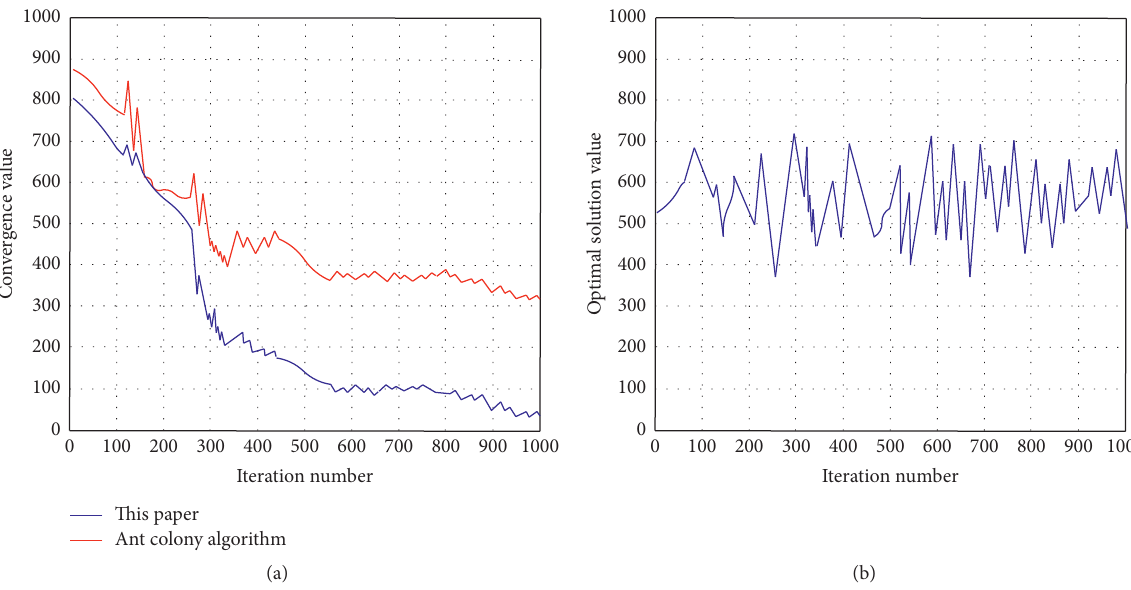
Figure 9: Convergence characteristics of the algorithm and diversity of solutions: (a) convergence performance of different algorithms; (b) diversity graph of the solution of this